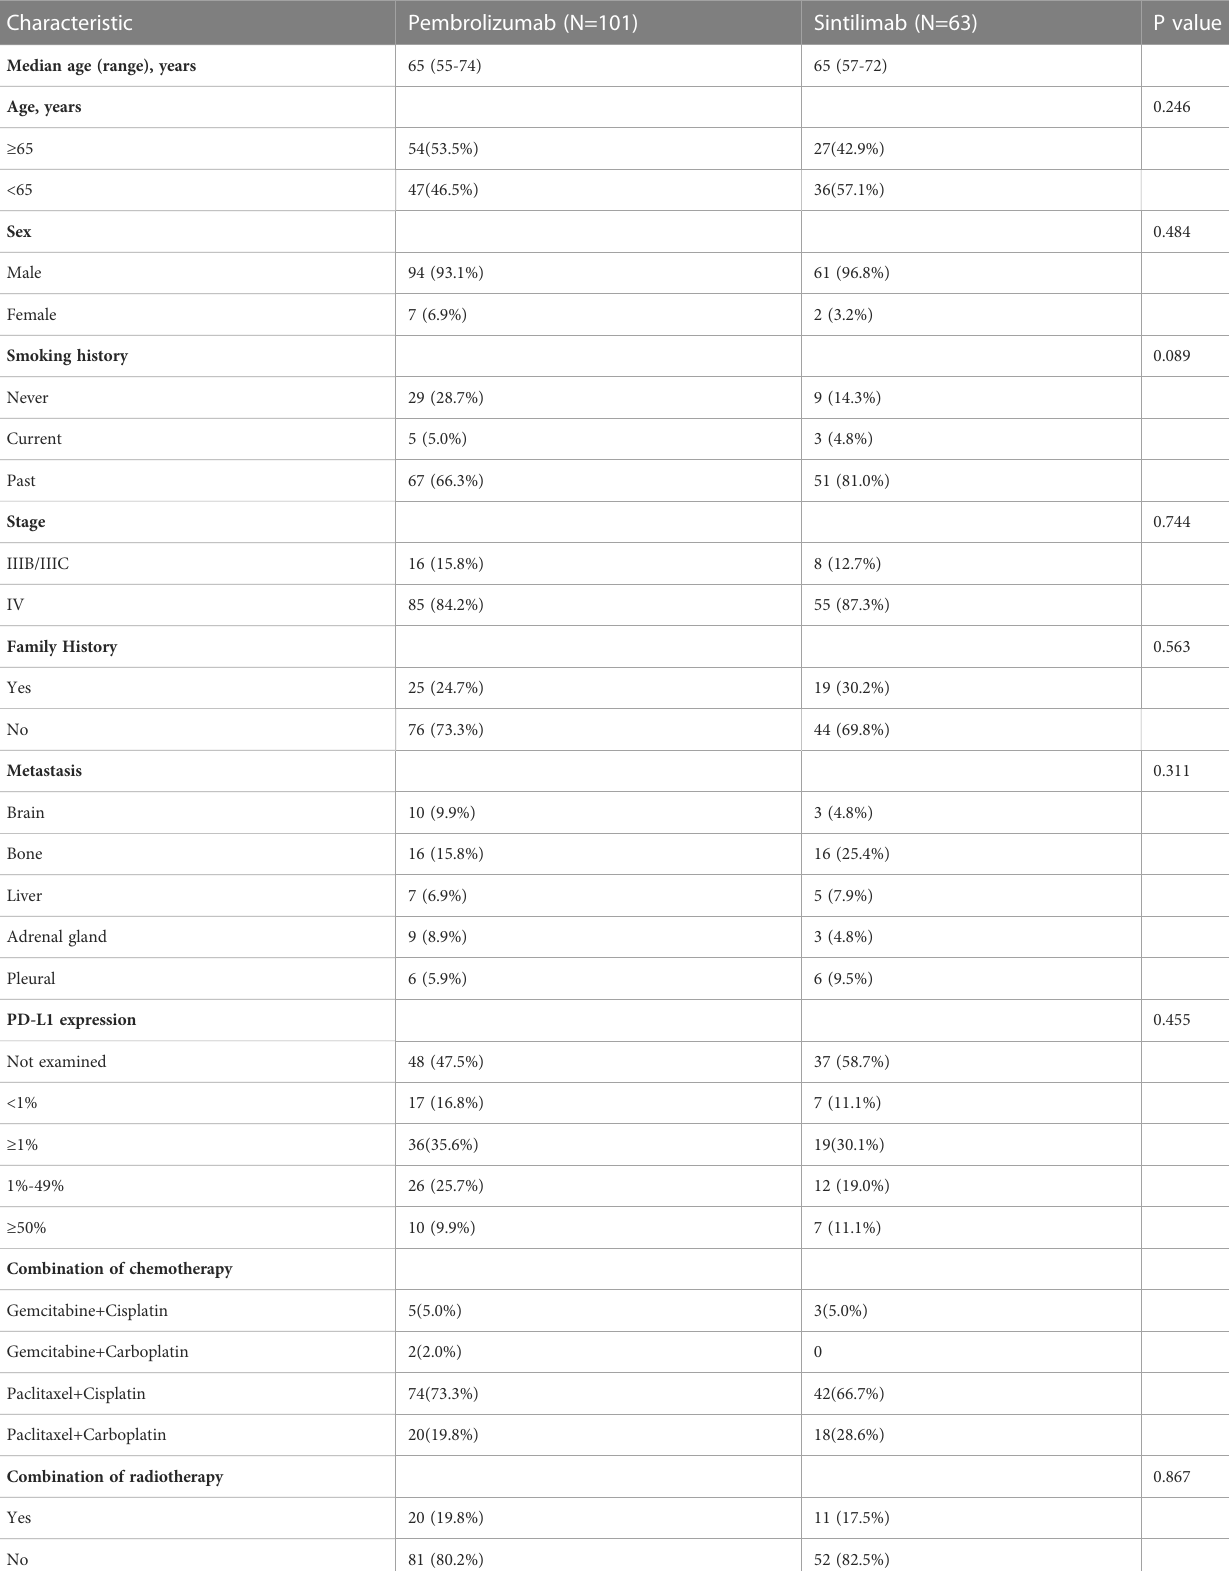
TABLE 1 Baseline characteristics of the study